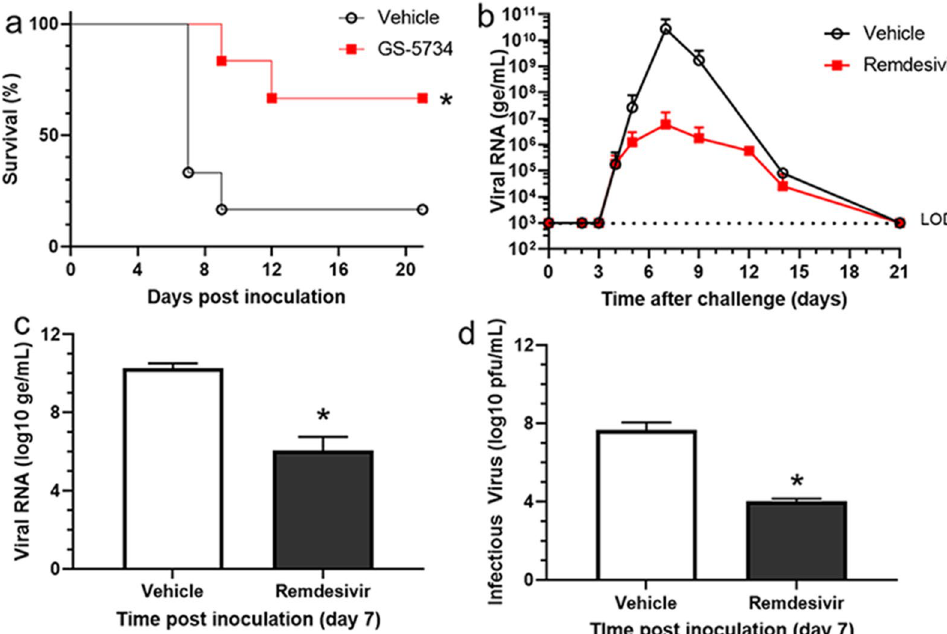
Figure 1. Survival and viremia. ( a ) Kaplan–Meyer survival curves show 1 of 6 survivors (17% survival) in the vehicle control group and 4 of 6 (67%) survivors in the remdesivir-treated group following aerosol delivery of EBOV, p = 0.032 using the log-rank Mantel-Cox test. ( b ) Group mean of plasma viral RNA concentrations indicated as genome equivalents/mL (ge/mL). Vehicle-treated NHPs are indicated by black open circles, and remdesivir-treated NHPs are indicated by red filled squares. LOD limit of detection. ( c ) Day 7 viral RNA levels. EBOV RNA (log 10 ge/mL) is significantly lower in the remdesivir treatment (filled bar) compared to vehicle controls (open bar) on day 7, p = 0.029 (Wilcoxon rank-sum test). ( d ) Infectious EBOV levels. Infectious EBOV (log 10 pfu/mL) is significantly lower with remdesivir treatment (filled bar) compared to vehicle controls (open bar) on day 7, p = 0.036 (Wilcoxon rank-sum test). Values represent the medians and interquartile ranges with statistically significant differences noted (*p < 0.05).